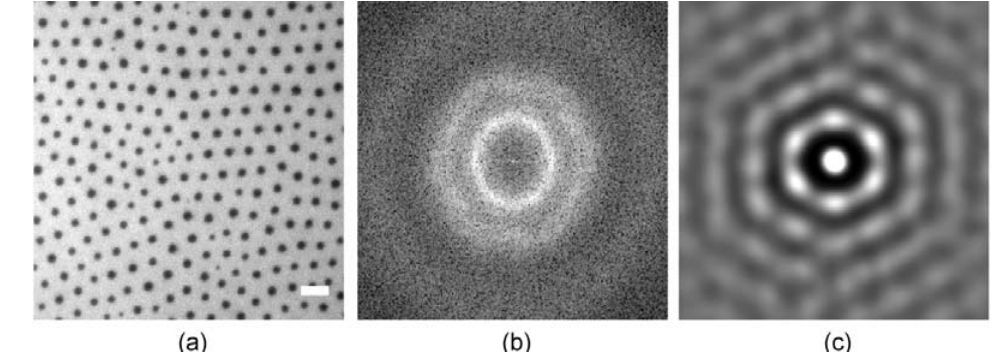
Figure 5. Structural characterization of FL10man domains (33 mol %) incorporated in a 1,2-Dioleoyl- sn -glycero-3-phosphocholine (DOPC) monolayer; ( a ) fluorescence image; ( b ) spectral density plot; ( c ) autocorrelation; ( d ) domain size distribution; ( e ) radial integration; and ( f ) polar intensity plot of nearest